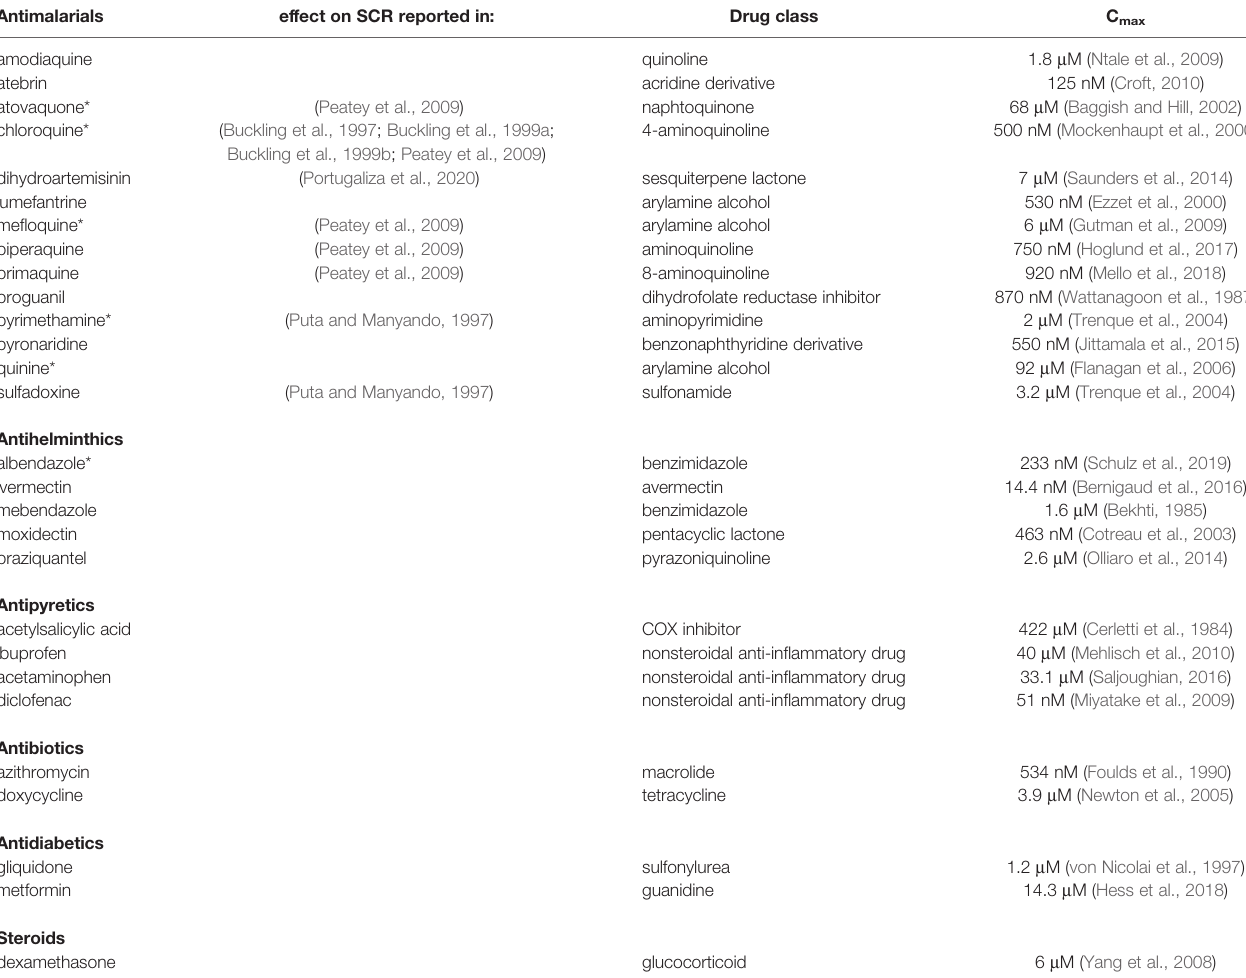
TABLE 1 | Compounds tested for activities on P. falciparum sexual commitment. Antimalarials effect on SCR reported